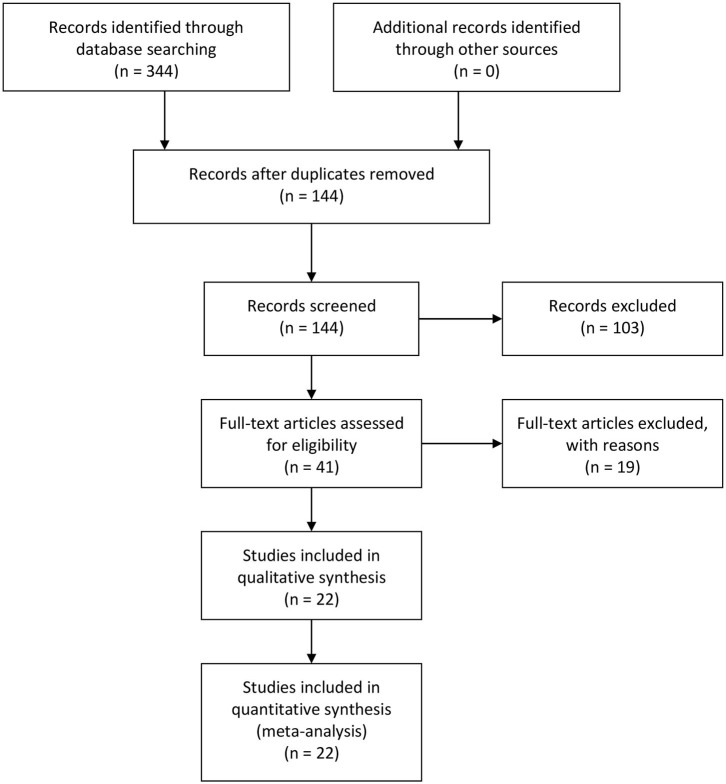
Flowchart of literature search.